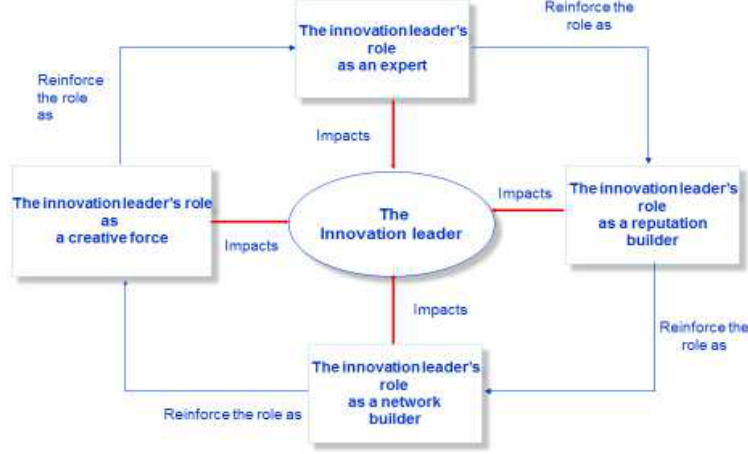
Fig. 1. The innovation leader in creative energy fields: different